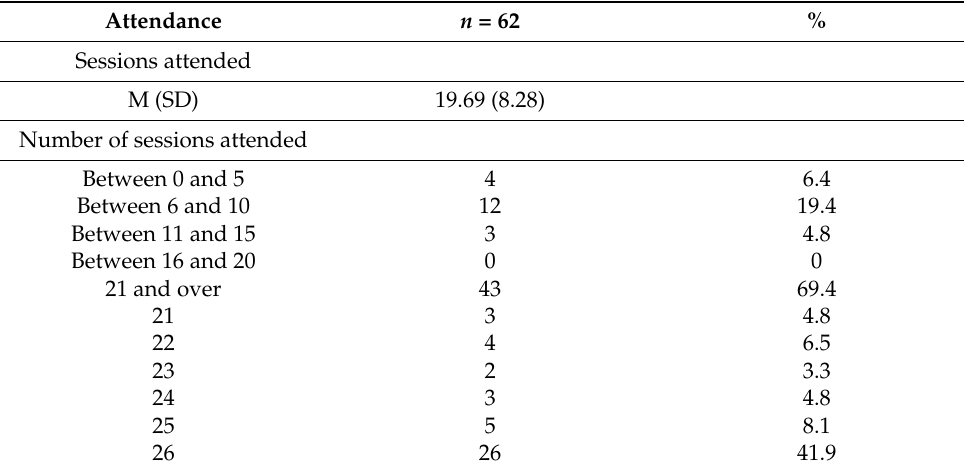
Table 3. Attendance to individual reminiscence therapy